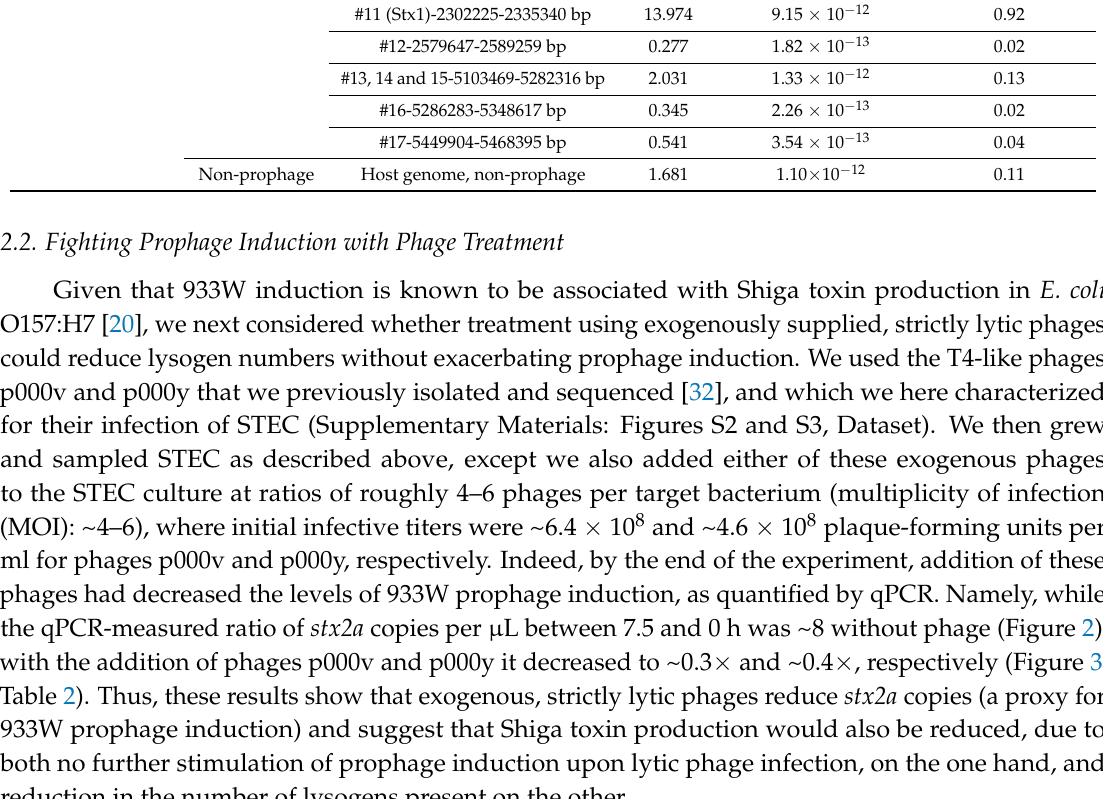
Table 2. Summary of the prophage induction quantification obtained by qPCR in uninfected and infected STEC cultures, as presented in Figures 2 and